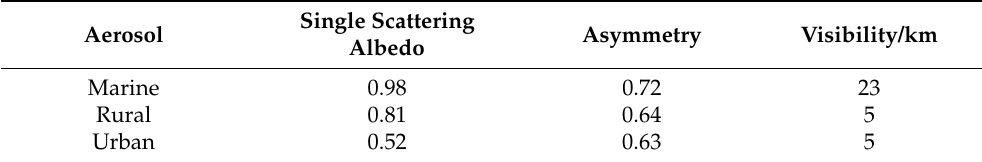
Table 4. Optical properties of different aerosols used in the radiance simulation.